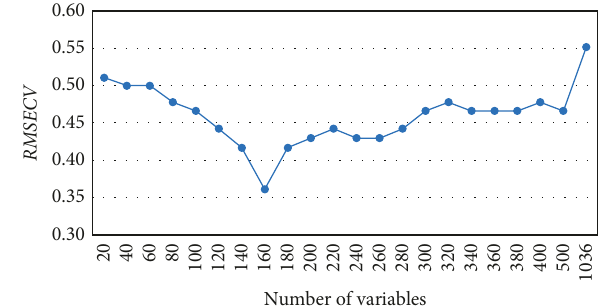
Figure 2: Variation of RMSECVs with the number of selected variables. RMSECV denotes root mean square error of cross-